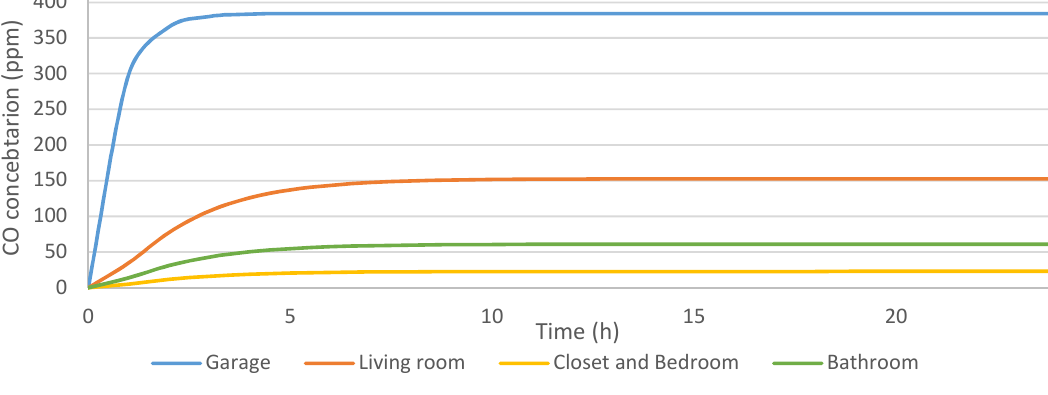
Figure 3. Results of the CONTAM simulation.